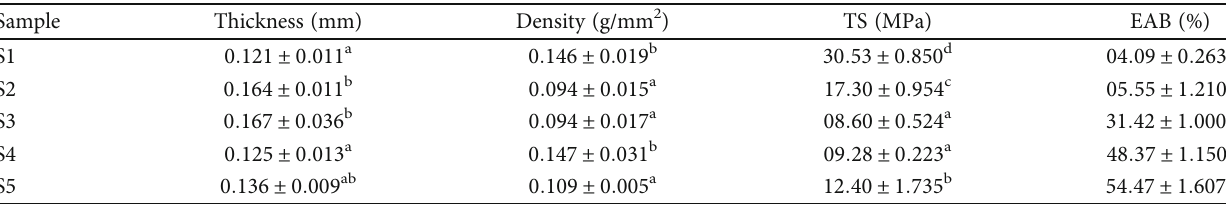
Table 1: Mechanical properties of the blend fi lms.